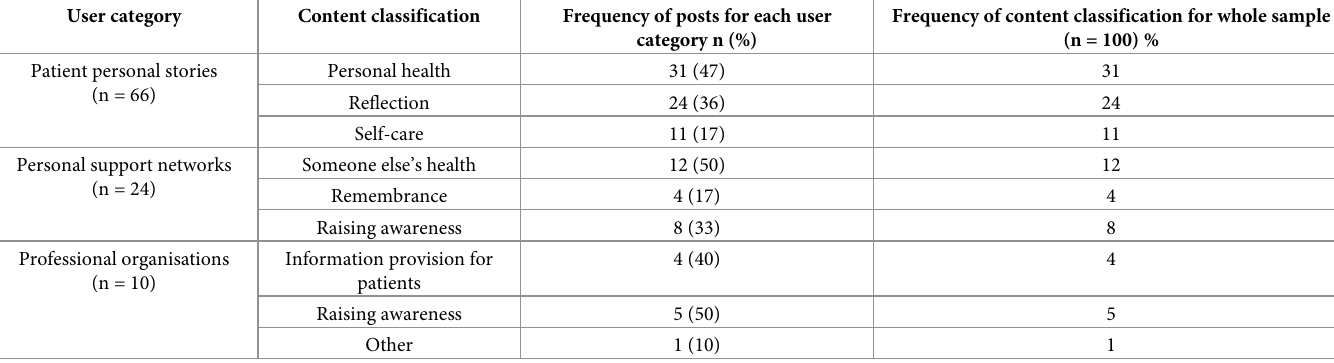
Table 3. The content classification frequency by user category and content